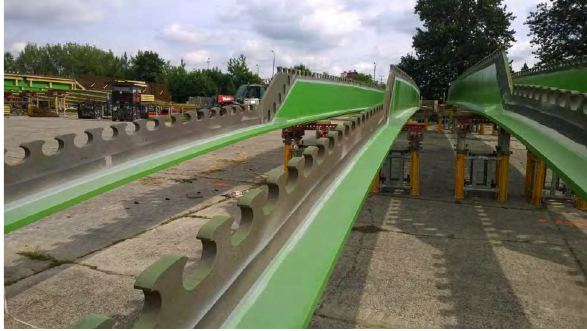
Figure 3: Steel T-sections of Elbląg bridge. High T-sections for mid- span regions, low T-sections for internal support regions